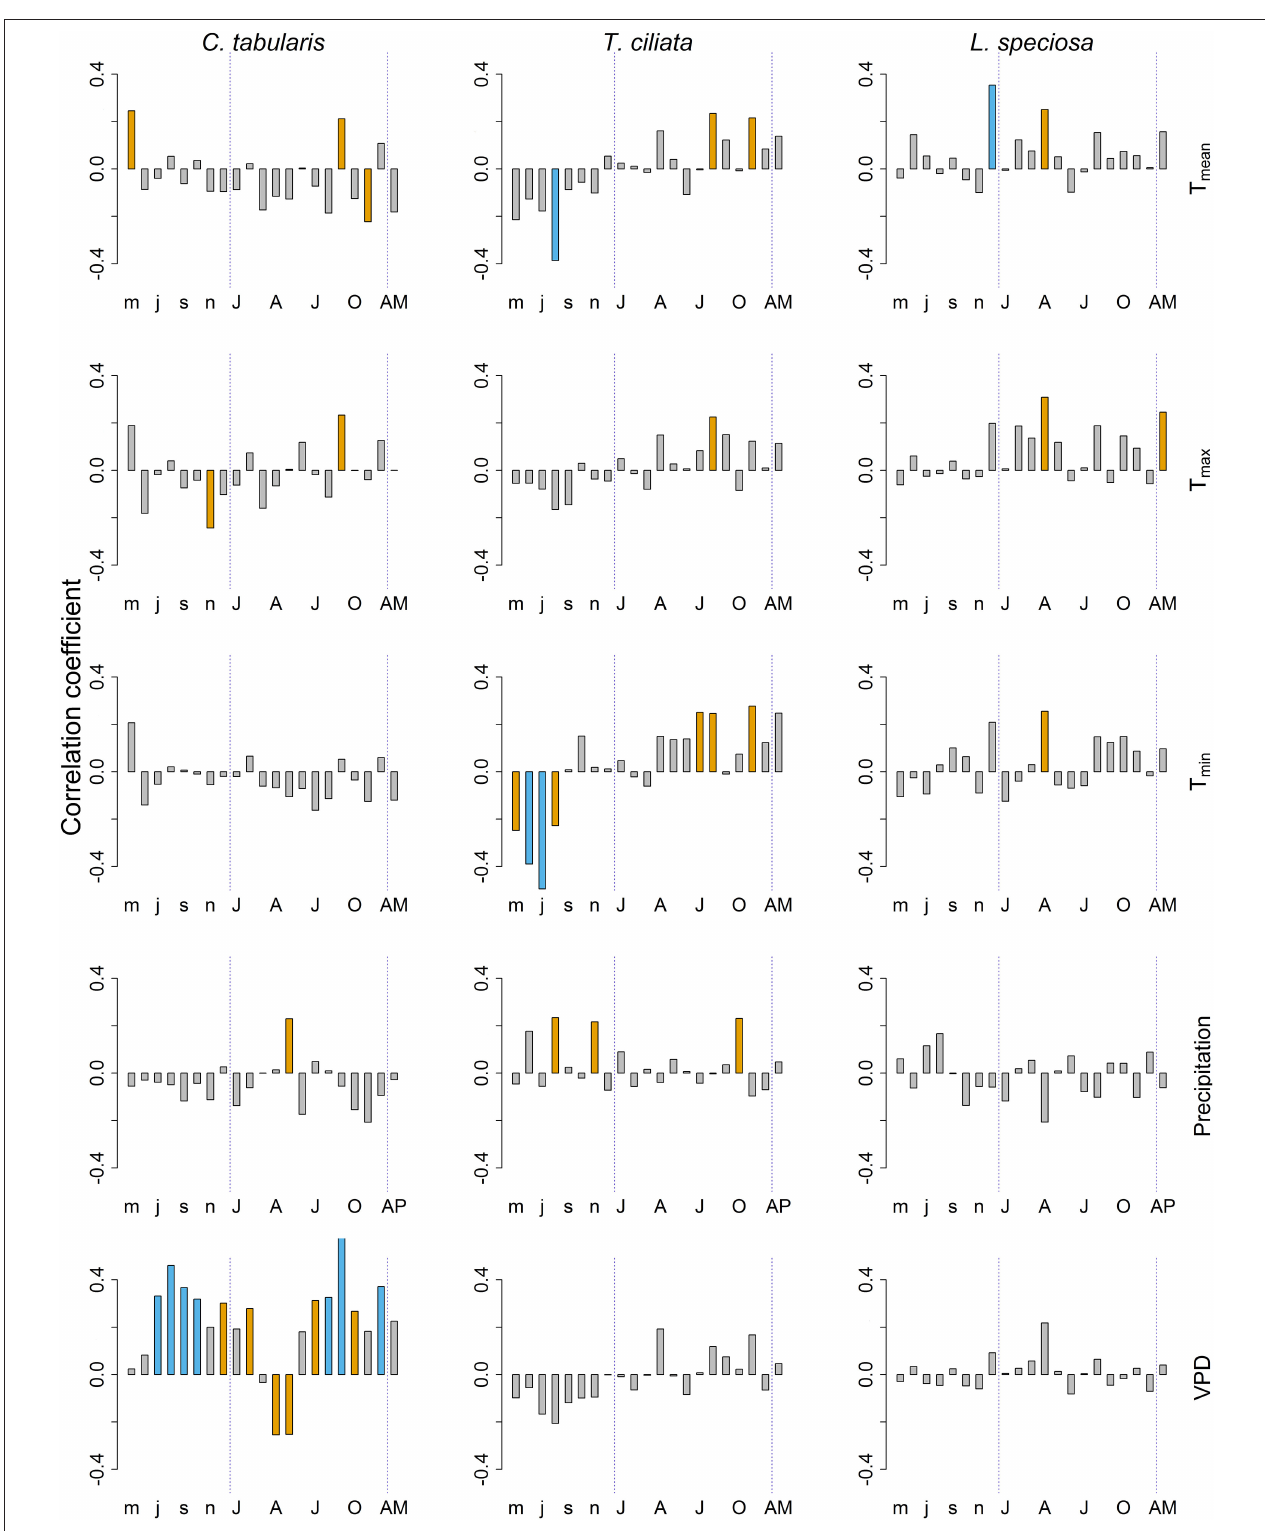
FIGURE 6 | Bootstrap correlations between climate variables and hydraulic efficiency (K S ) of three South Asian tropical moist forest tree species. Orange and blue bars indicate correlations significant at p < 0.05 and p < 0.01 levels, respectively. Lower case letters represent months of the previous year. Upper case letters represent months of the current year. AM, Annual mean; AP, Total annual precipitation.